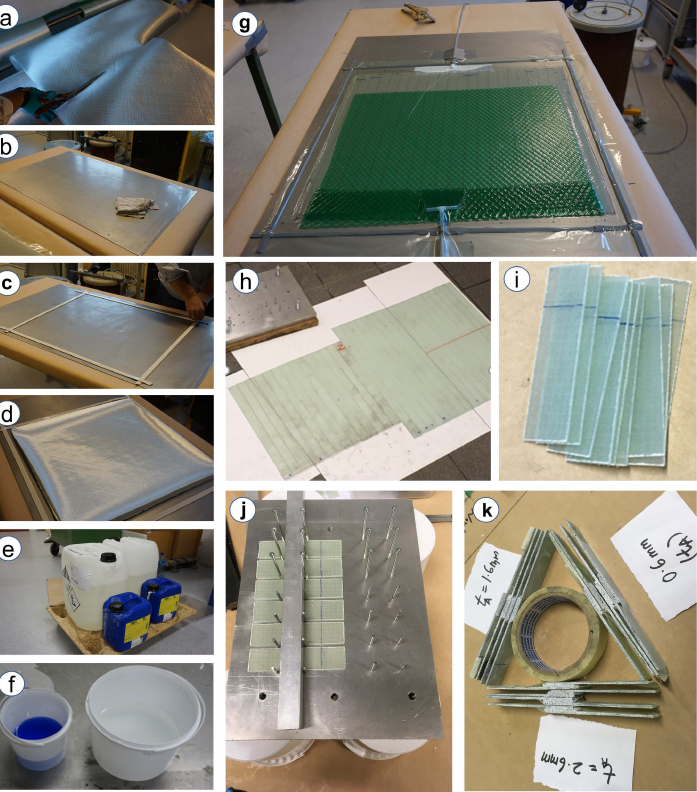
Figure 6. Step-by-step procedure ( a – k ) followed in experiment for preparing laminates and adhe- sive